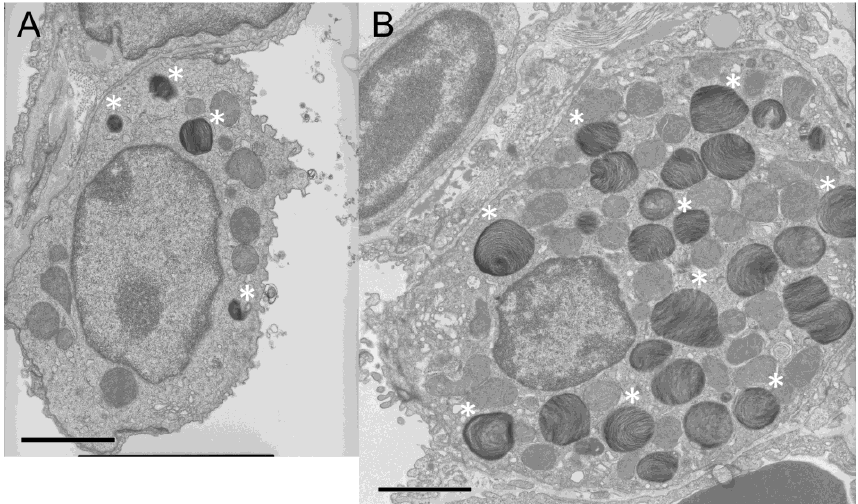
Figure 3. Electron microscopic image of an alveolar type II cell. ( A ) Wild-type C57BL/6J mouse. ( B ) Chocolate mouse. Some of the lamellar bodies are indicated by asterisks (*). The bar indicates 2.5 μm. Compared with wild-type mice, chocolate mice show enlarged alveolar type II cells filled with lamellar bodies of increased size and number.